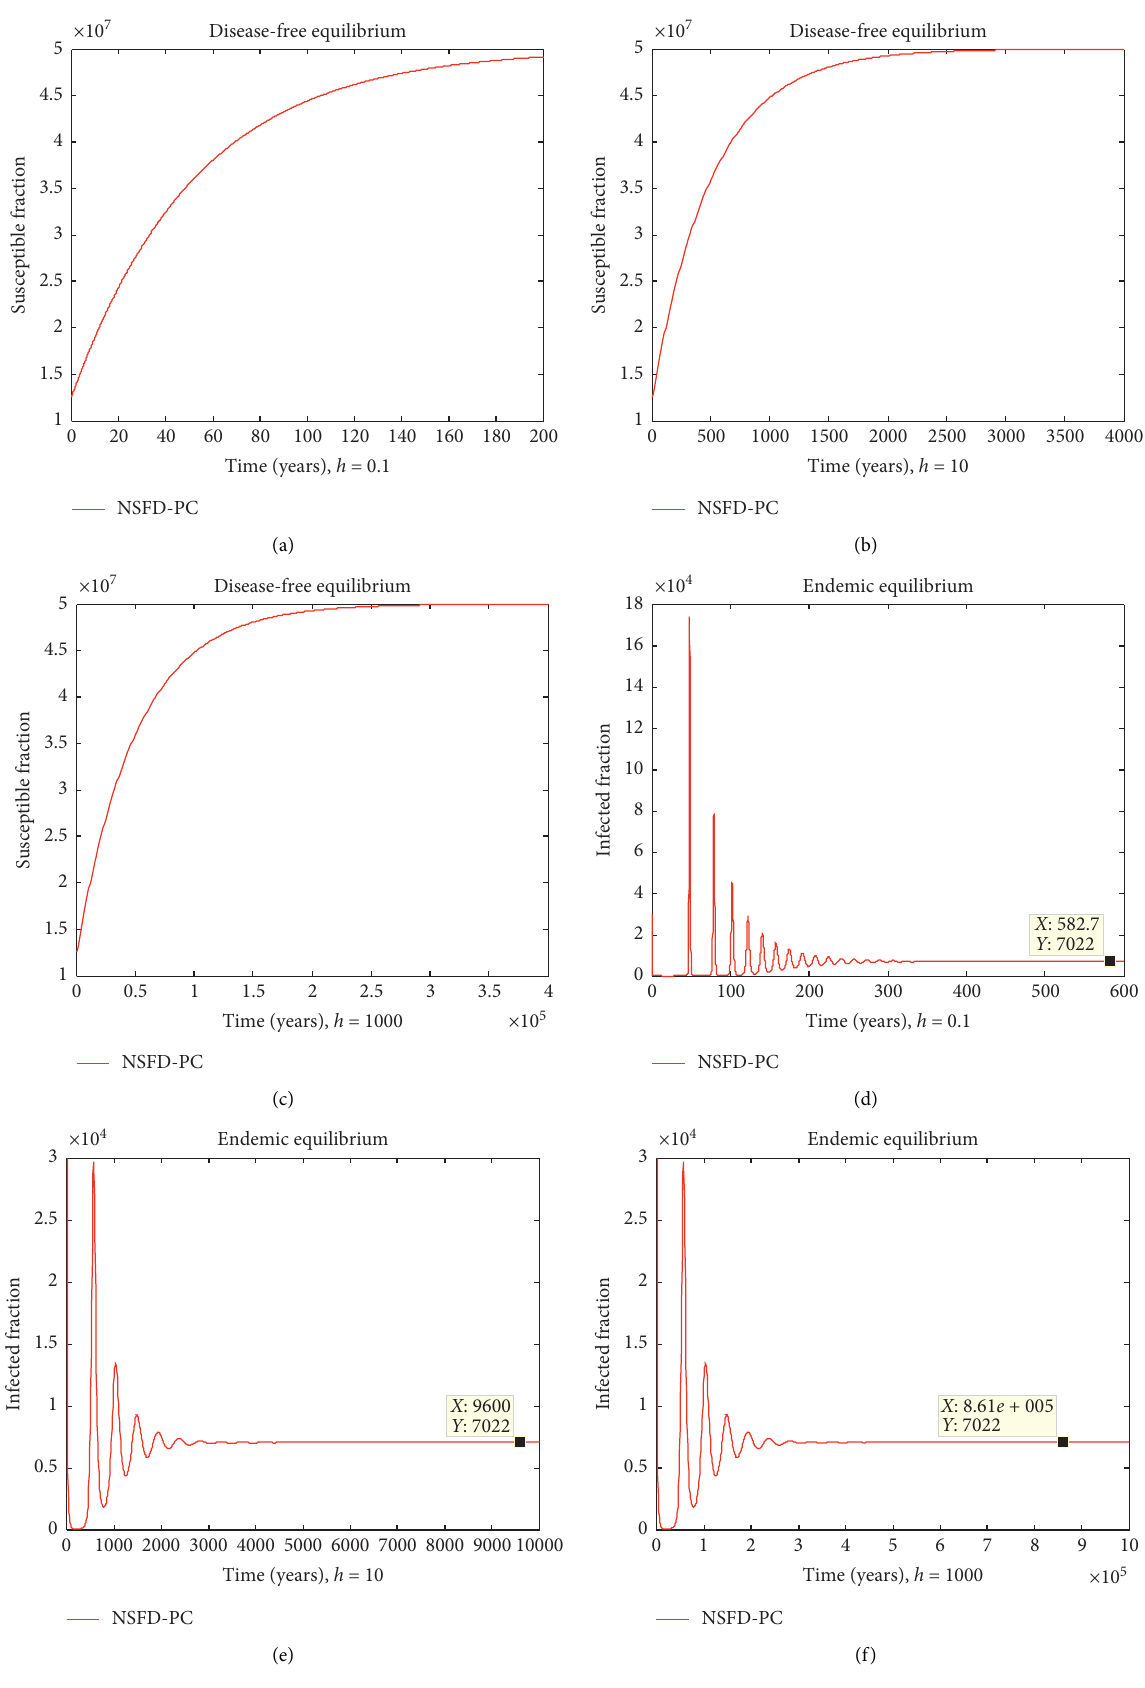
Figure 4: Time plots of susceptible and infected population using the NSFDPC method with different step sizes: (a) h � 0 . 1, (b) h � 10, and (c) h � 1000